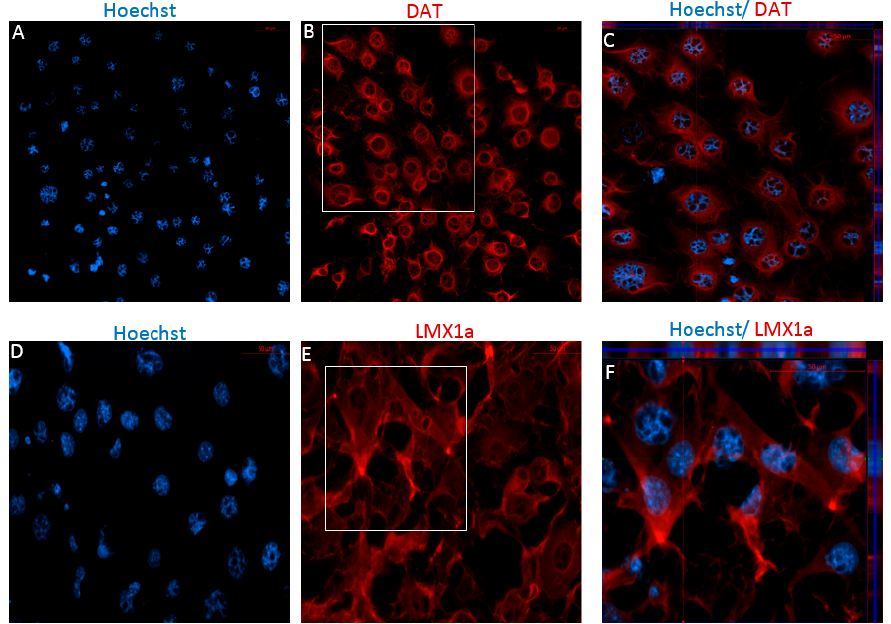
Figure 9. Immunocytochemistry/immunofluorescence (ICC/IF) performed on P40 MSCs following Stage Two of the IDI. Hoechst-labeled P40 MSCs ( A , D ) the mature dopaminergic marker, DAT (( B ) red), and the immature dopaminergic marker, LMX1a (( E ) red), following exposure to SHH, FGF-8, and BDNF (right). There was no bright staining detected for TH for P40 differentiated cells (image not included). Orthogonal displays of z -stacks are represented in merged images ( C , F ).